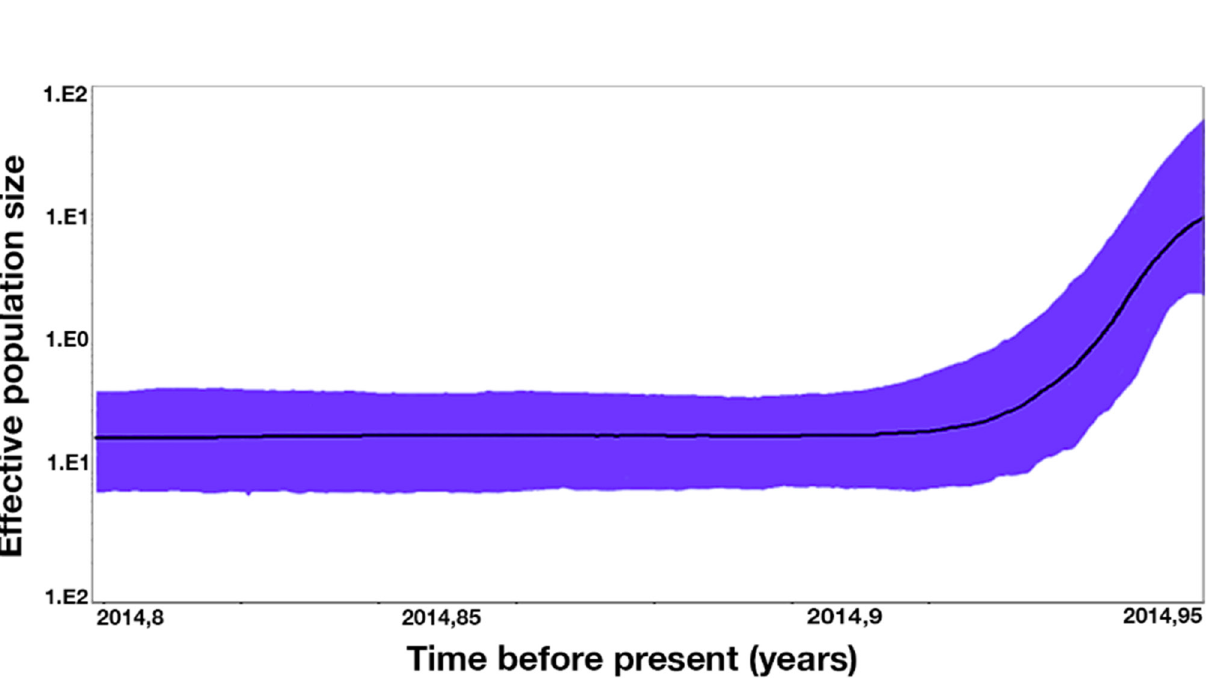
FIGURE 4 | Bayesian skyline plot (BSP) showing change in effective population size of Prochilodus lineatus in Feb_15 group from Cachoeira de Emas in the Mogi-Guaçu River based on Dloop marker. The y-axis, population size × generation time*; x-axis, time (indicated in thousands of years ago). *Generation time measured in million years. Solid lines represent median estimates, and shaded areas represent the 95% HPD